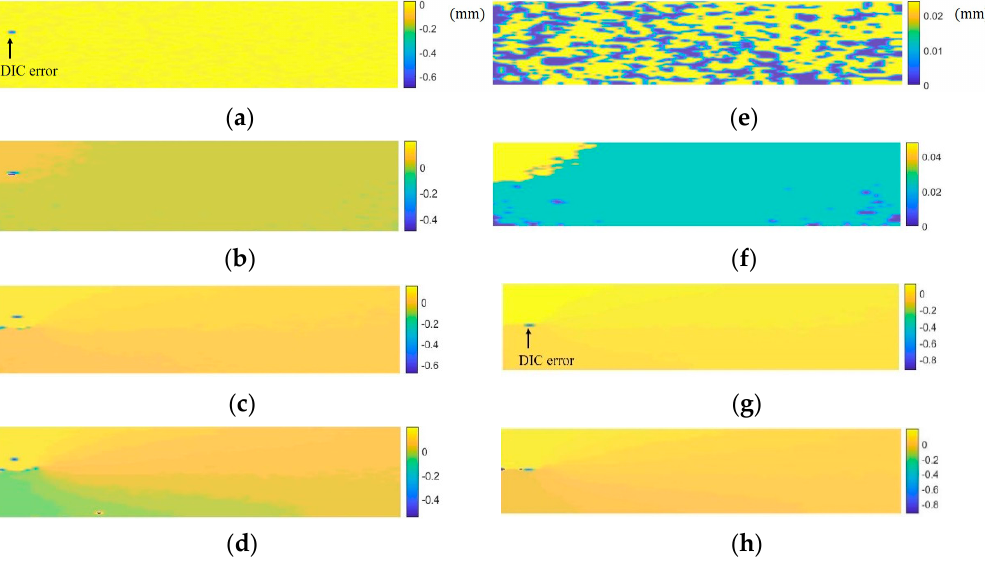
Figure 13. DIC analysis results using SSSIG. The subset size of 13 × 13 pixels with uniaxial tensile conditions of: ( a ) 0.2, ( b ) 1.0, ( c ) 1.4 and ( d ) 1.7 mm; the subset size of 19 × 19 pixels with uniaxial